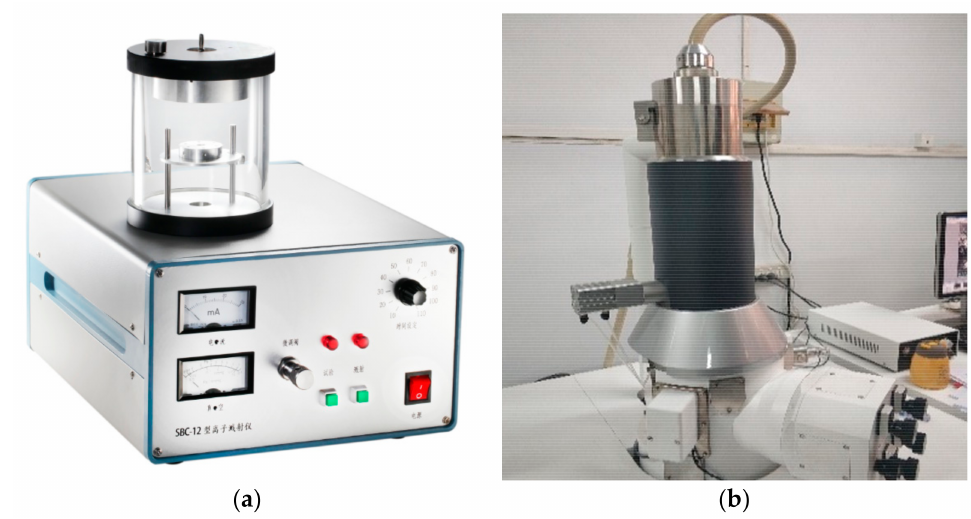
Figure 3. Ion sputtering instrument ( a ) and scanning electron microscope ( b ).